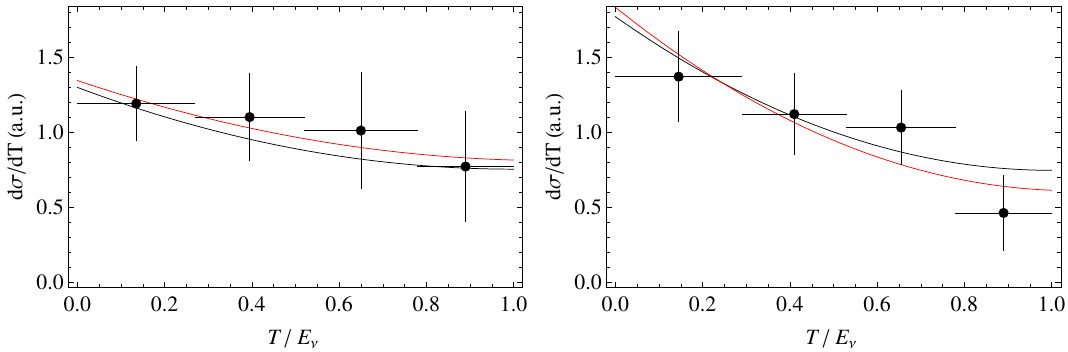
Figure 4 . Di(cid:11)erential cross sections of (cid:23) (cid:22) + e (cid:0) (left) and (cid:23) (cid:22) + e (cid:0) (right) measured in CHARM-II. The black points represent the data of CHARM-II measurement, taken from [39]. The black and red curves are the SM prediction and the best (cid:12)t, respectively.